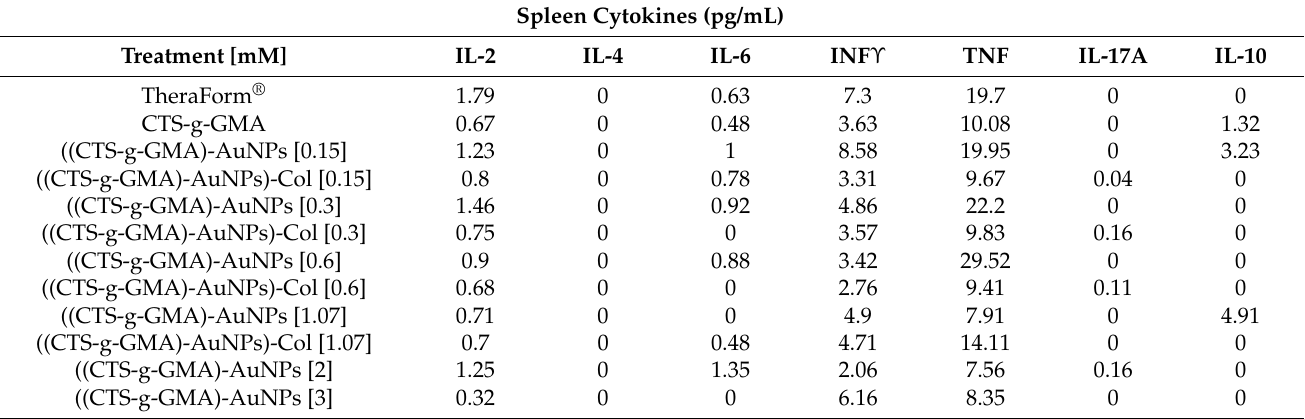
Table 3. Induction of spleen cytokines due to exposition with Au nanocomposites and collagen. Spleen Cytokines